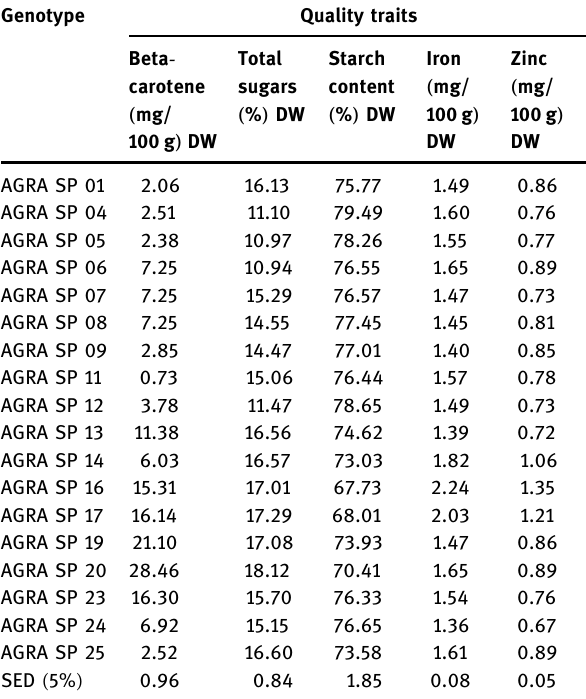
Table 6: Quality traits of the sweetpotato genotypes across ecozones over two years Genotype Quality